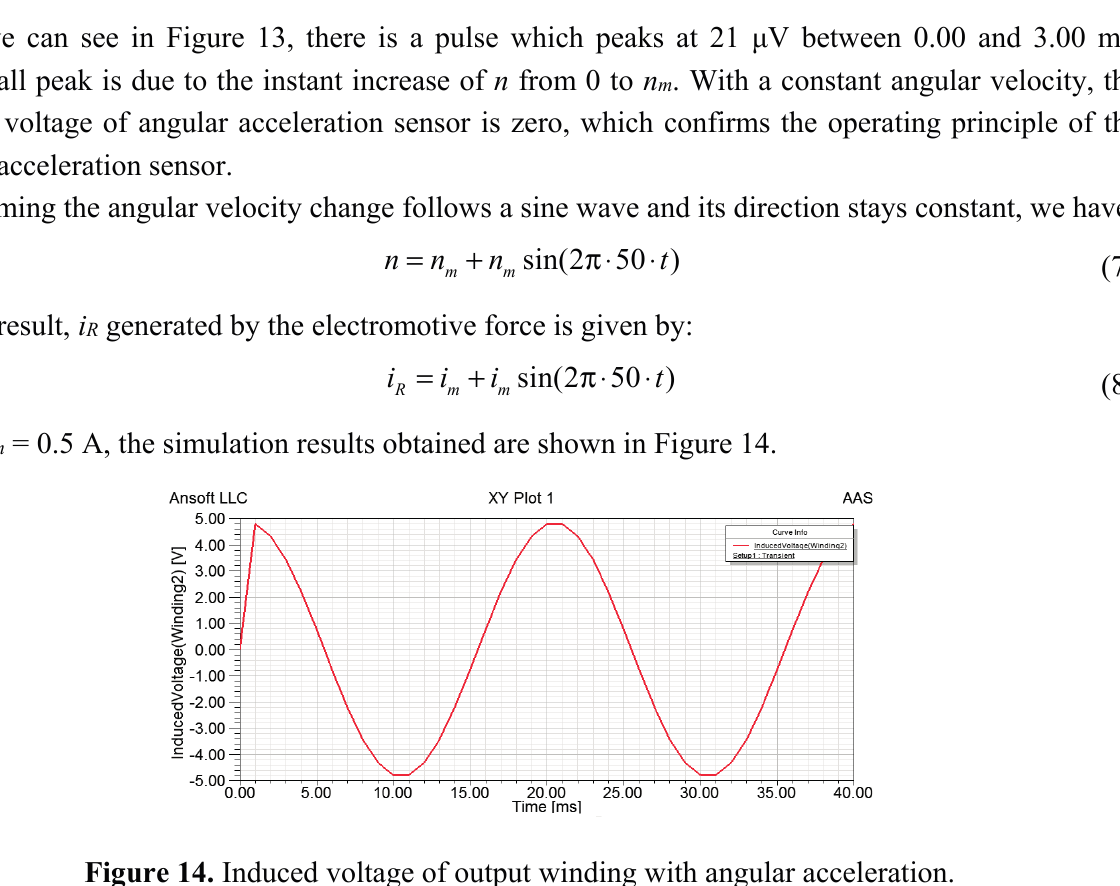
Figure 13. Induced voltage of output winding without angular acceleration.